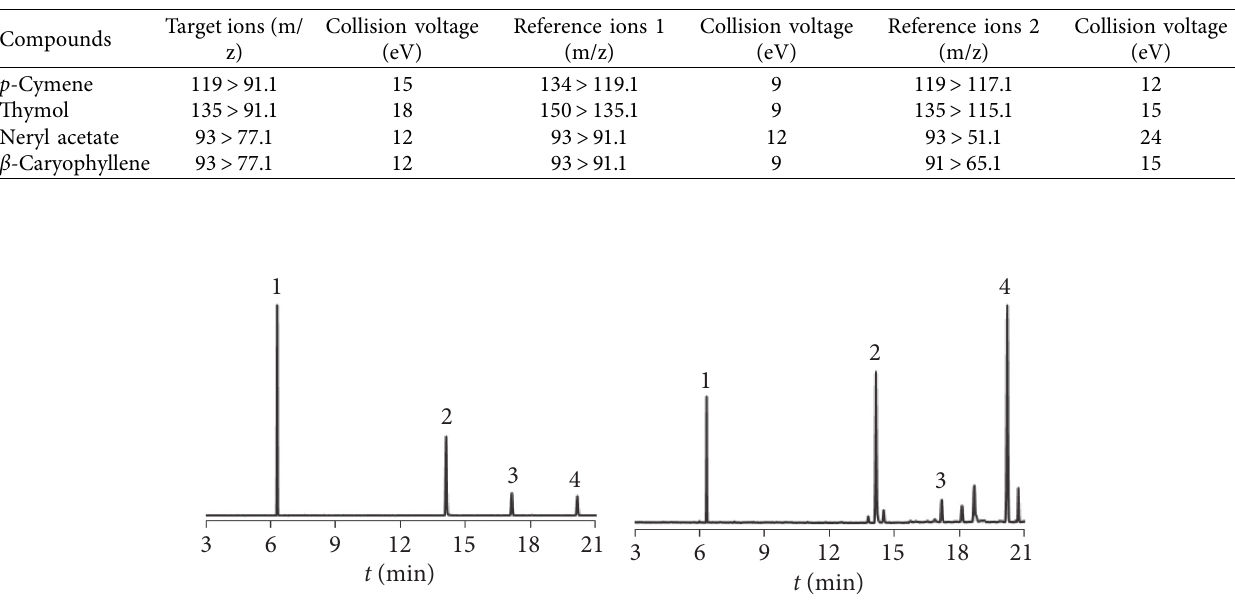
Table 1: Target ion pair, reference ion pairs, and collision voltage of compounds.